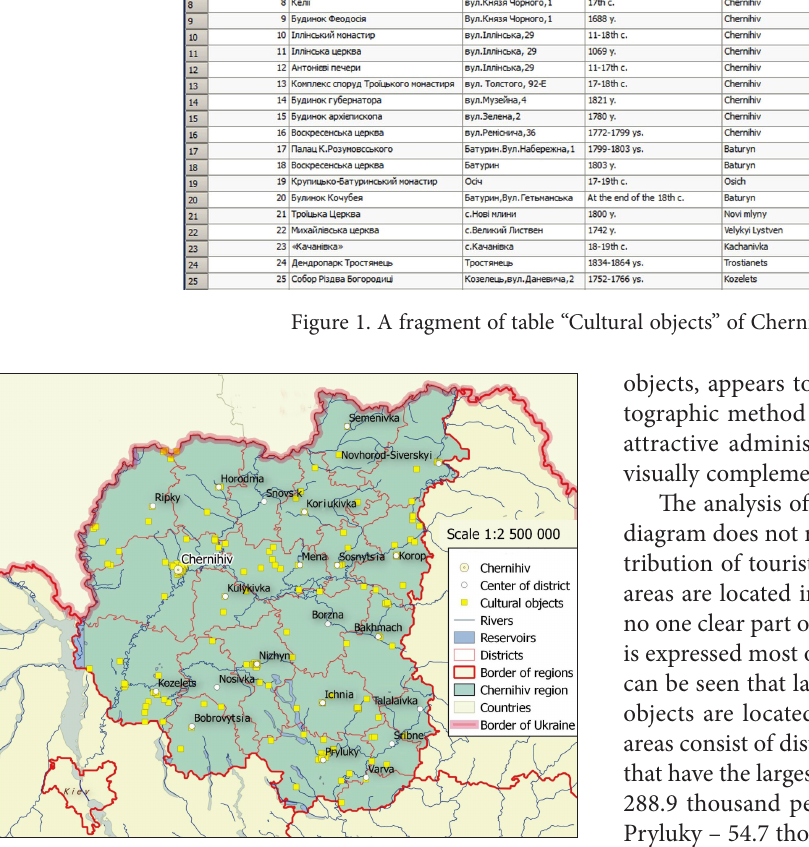
Figure 2. A map of historical and cultural objects of Chernihiv region